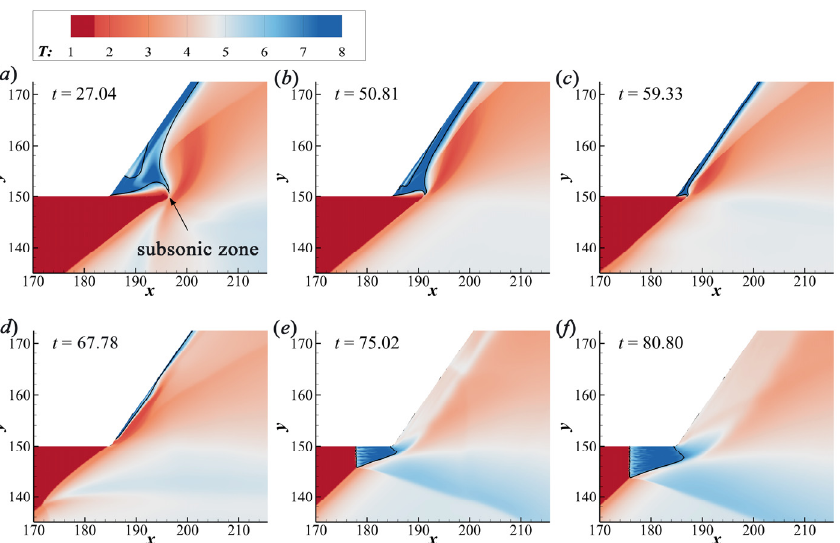
Figure 10. Local temperature fields (with the black line denoting sonic curves) of ODWs when M 0 decreases at different instants. ( a ) t = 27.04, ( b ) t = 50.81, ( c ) t = 59.33, ( d ) t = 67.78, ( e ) t = 75.02, ( f ) t =